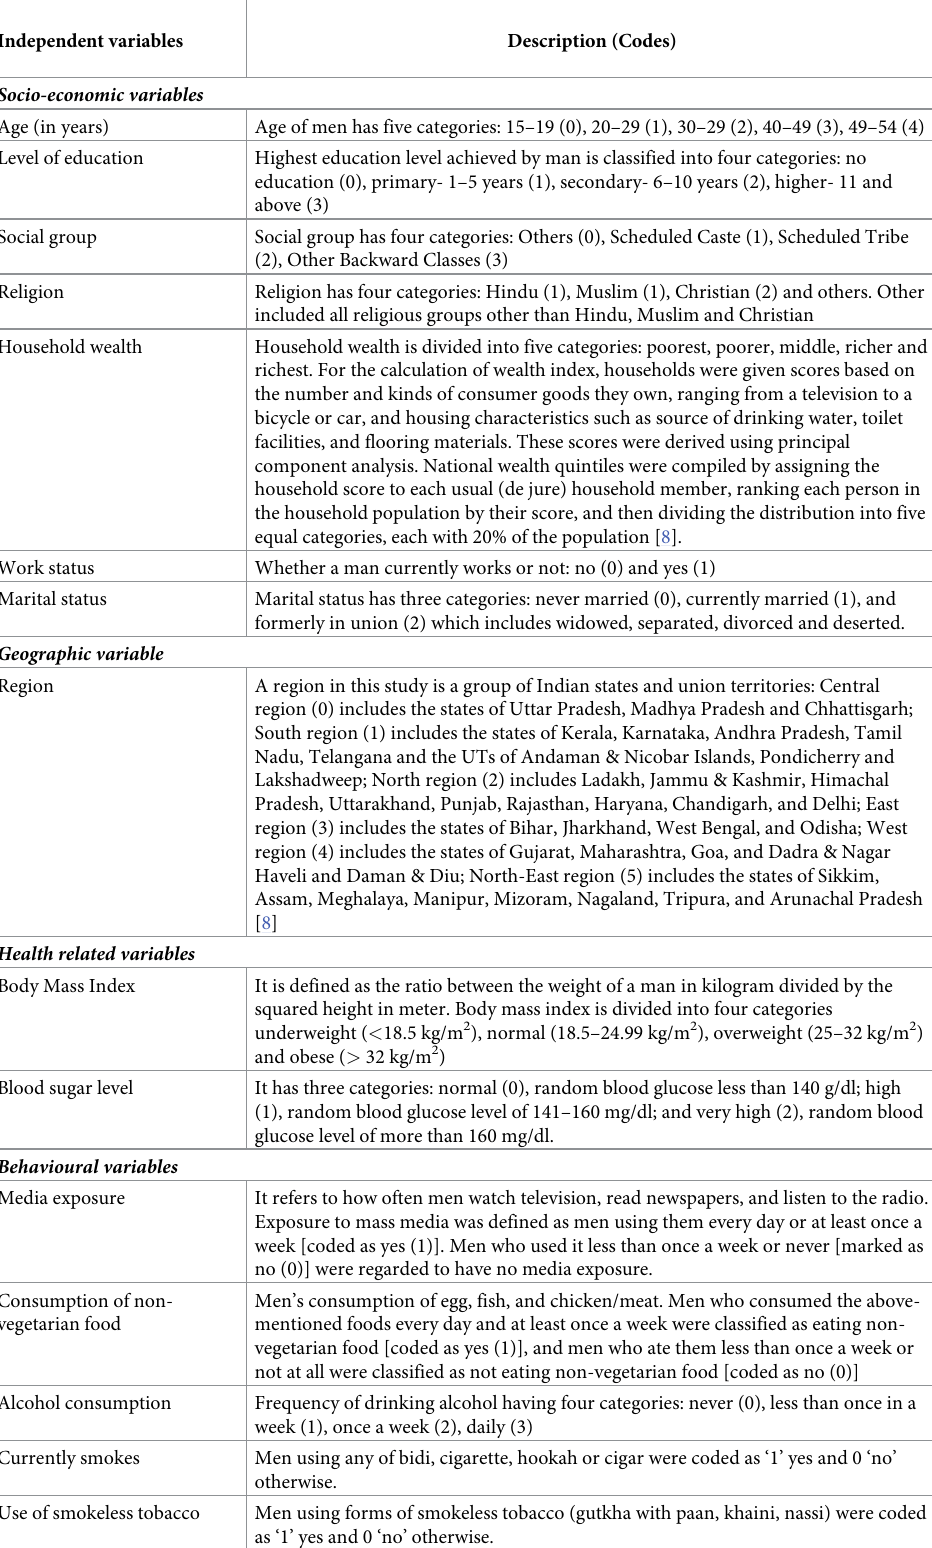
Table 1. Description of the